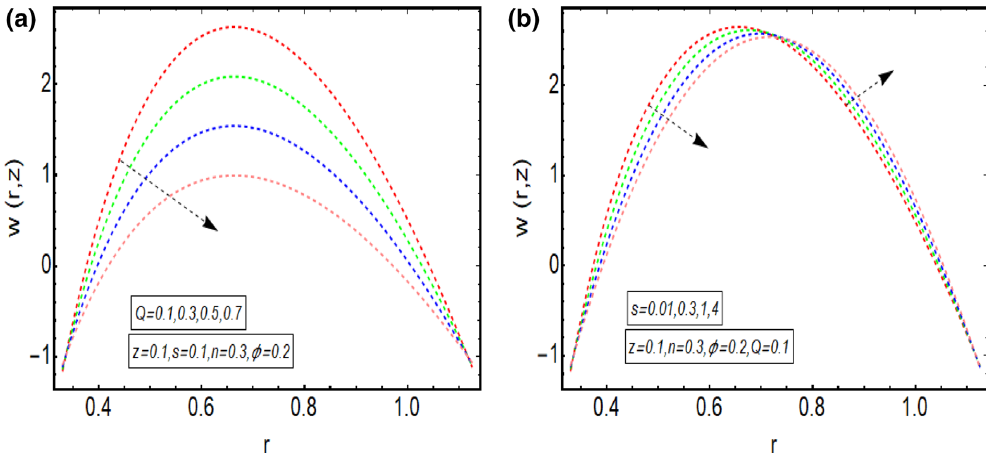
Figure 2. ( a ) Velocity plot for four values of Q . ( b ) Velocity plot for four values of s